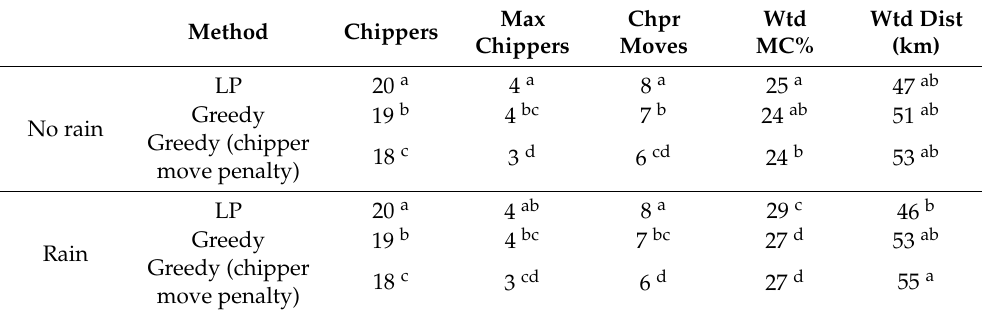
Table 7. Comparison between LP solver and Greedy algorithm results with and without a chipper move penalty and with and without simulated rainfall in the first week. Only test criteria with significant differences are